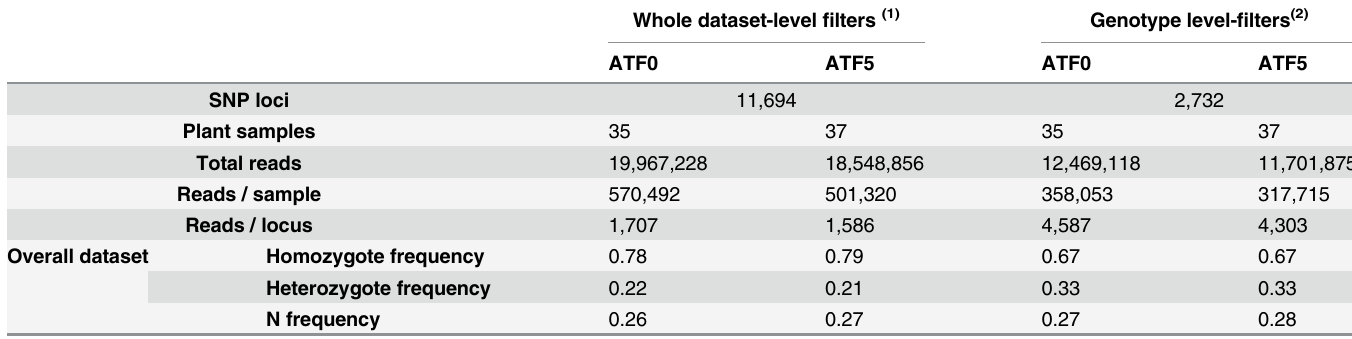
Table 3. Summary statistics of GBS analysis of two alfalfa populations with UNEAK using whole dataset-level filters 1 and genotype-level filters 2